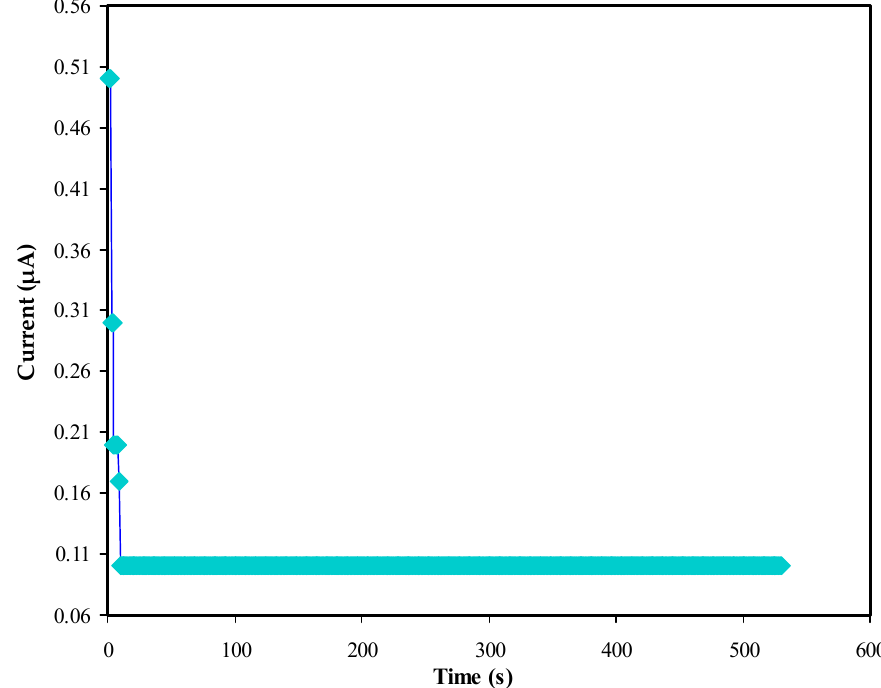
Figure 10. Polarization current vs. time for the BGNN5 system (t ion = 0.8 and t e = 0.2).